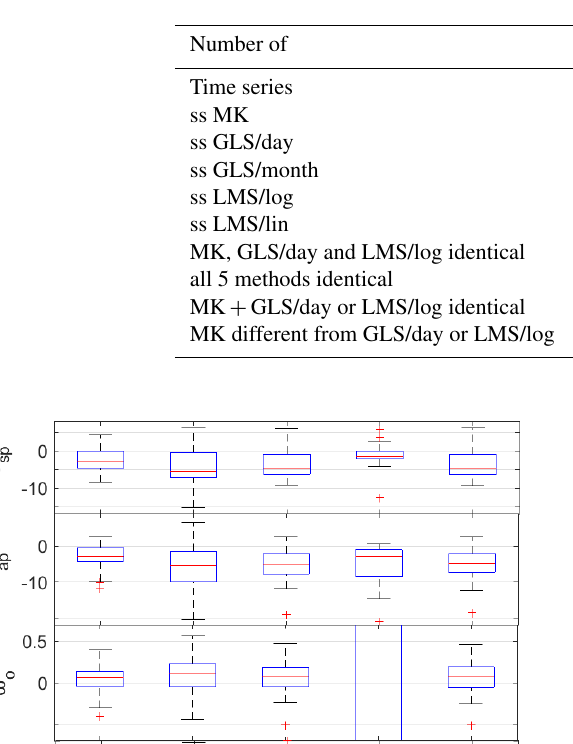
Table 3. Number of trends analyzed for each parameter, of ss cases for each trend analysis method, of trends with similar statistical signif- icance in MK, GLS/day and LMS/log, of trends with similar statistical significance for all five methods, of trends with at least GLS/day or LMS/log ss similar to MK, and of trends with no agreement between these two methods and MK ss.